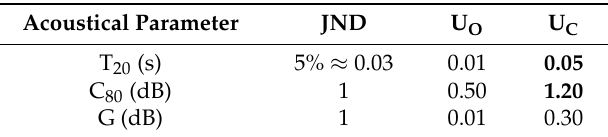
Table 3. Just Noticeable Difference (JND) of the T 20 , C 80 , and G acoustical parameters, the expanded uncertainty due to the variability of the input values of α w and s for the simulation software O and C (U O and U C ). Values higher than the JNDs are reported in